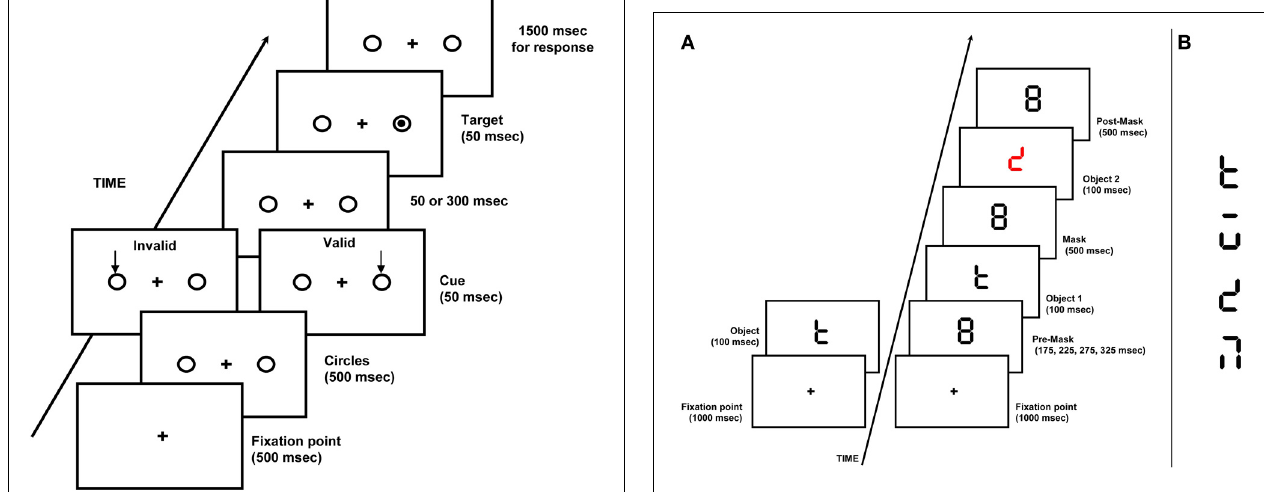
FIGURE 1 | Schematic representation of the display used in the visual spatial attention task.